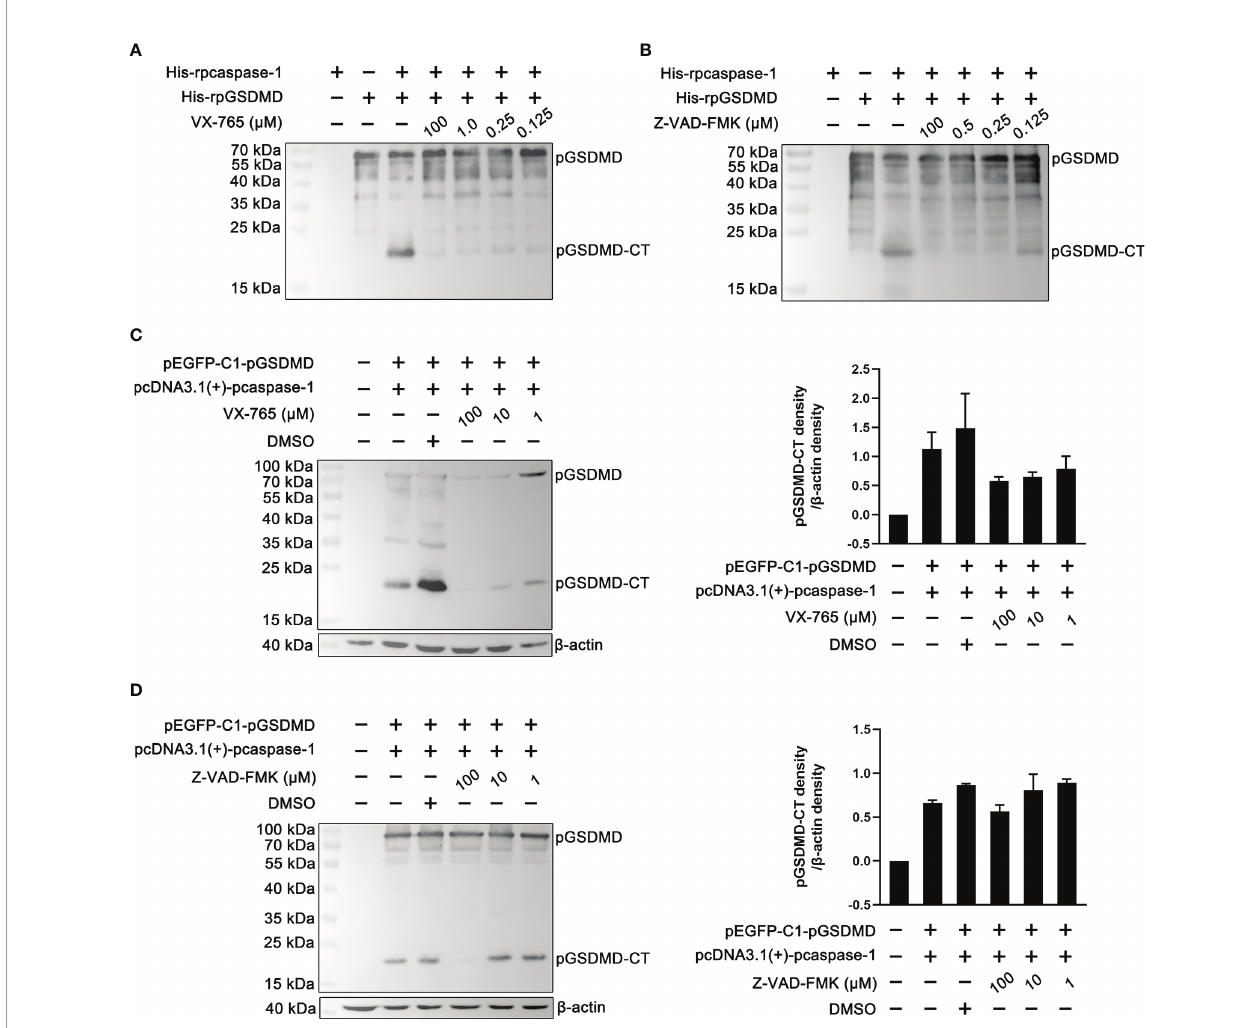
FIGURE 4 | The effect of VX-765 and Z-VAD-FMK on the cleavage of pGSDMD by pcaspase-1. His-rpGSDMD was incubated with His-rpcaspase-1 in the presence of VX-765 (A) or Z-VAD-FMK (B) , the mixtures were analyzed by western blot analysis using mouse anti-rpGSDMD mAb. HEK293 cells were transfected with pEGFP-C1-pGSDMD and pcDNA3.1(+)-pcaspase-1 simultaneously, and then, VX-765 (C) or Z-VAD-FMK (D) were used to treat the cells for 18 h. The whole cell lysates were analyzed by mouse anti-rpGSDMD mAb based western blot assay(left panel). The density of pGSDMD-CT bands was quanti fi ed using the ImageJ software and normalized to b -actin (right panel).